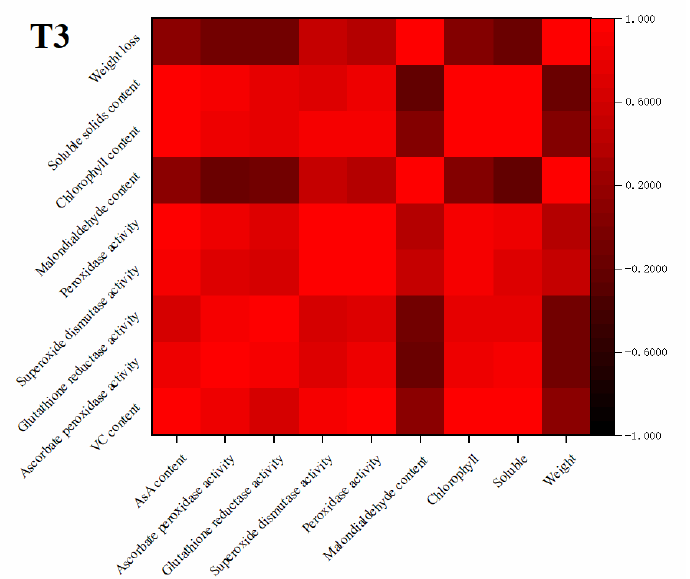
Figure 11. Correlation of AsA content with APX activity, GR activity, SOD activity, POD activity, MDA content, soluble solids content, weight loss, and chlorophll content.